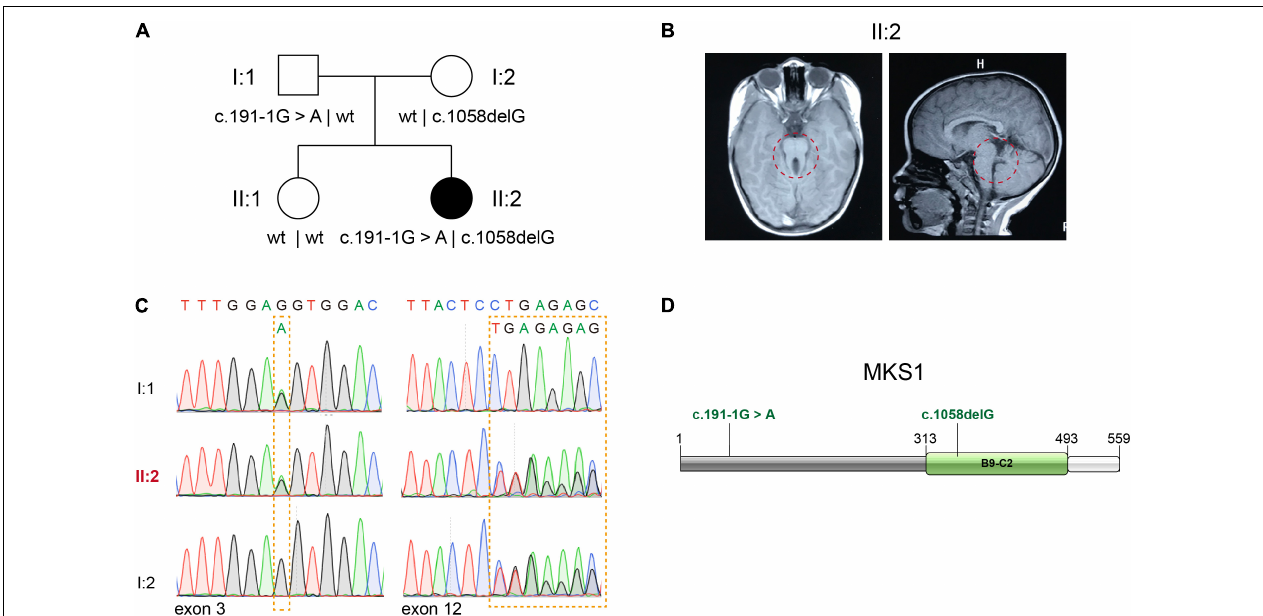
FIGURE 1 | Identification of novel MKS1 mutations in a patient with Joubert syndrome. (A) Pedigree of family referred for a clinical diagnosis of Joubert syndrome (JBTS). (B) Brain MRI of the proband showing the typical molar tooth sign and cerebellar vermis hypoplasia. (C) Electropherograms of Sanger sequences showing MKS1 sequences of the proband and her parents. (D) Schematic diagram of MKS1 domain structure and the mutations of the affected individual. The B9 domain is labeled as B9-C2.